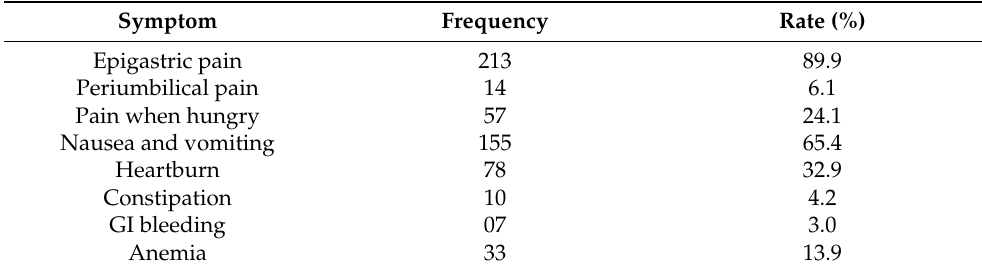
Table 2. Primary gastrointestinal symptoms of patients ( n =